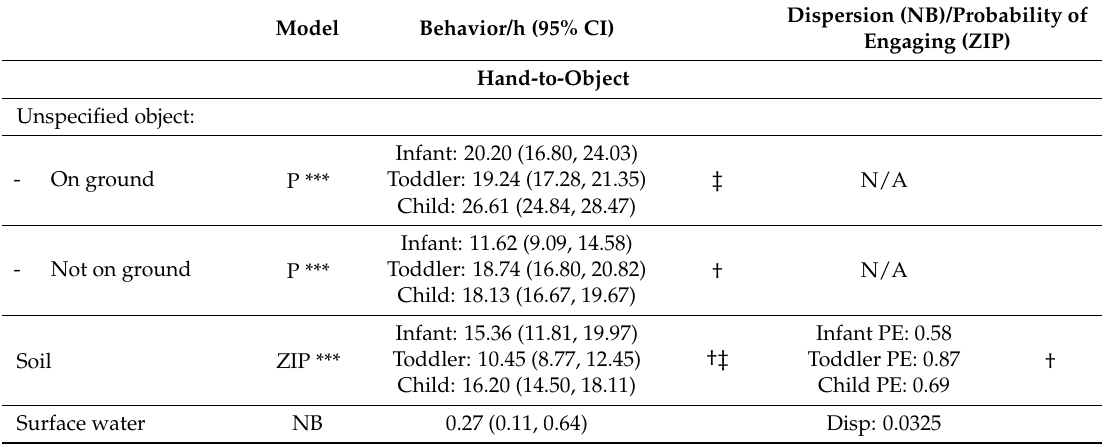
Table 4. Estimated rates of hand and mouth contact with environmental hazards and related hygiene and sanitation